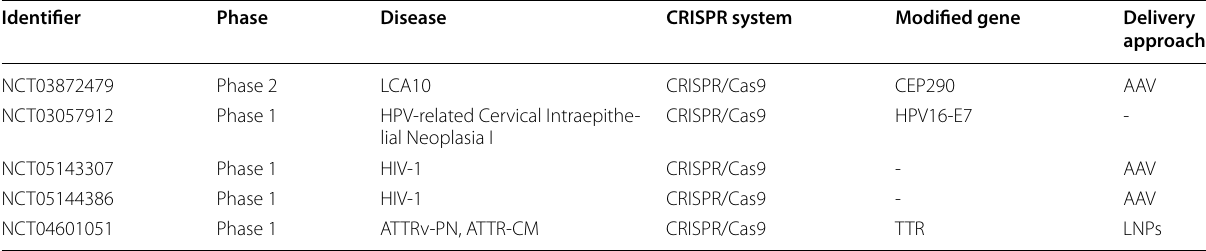
¶ Data were obtained from ClinicalTrials.gov and PubMed